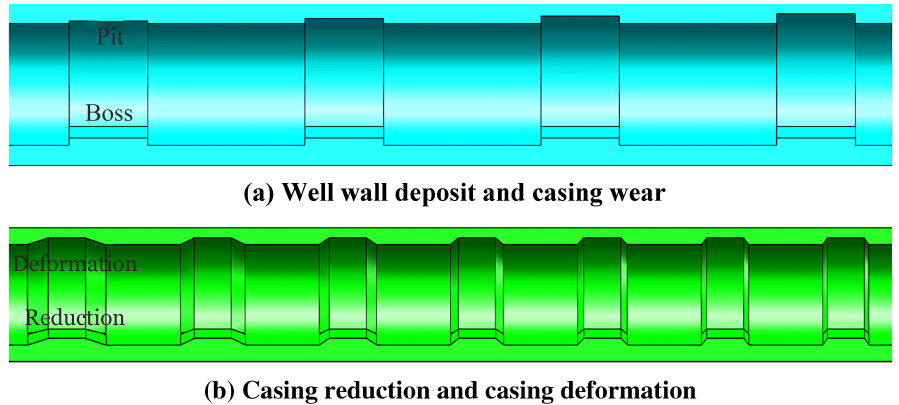
Figure 7. Simulated well wall deposit and casing wear, casing reduction and casing